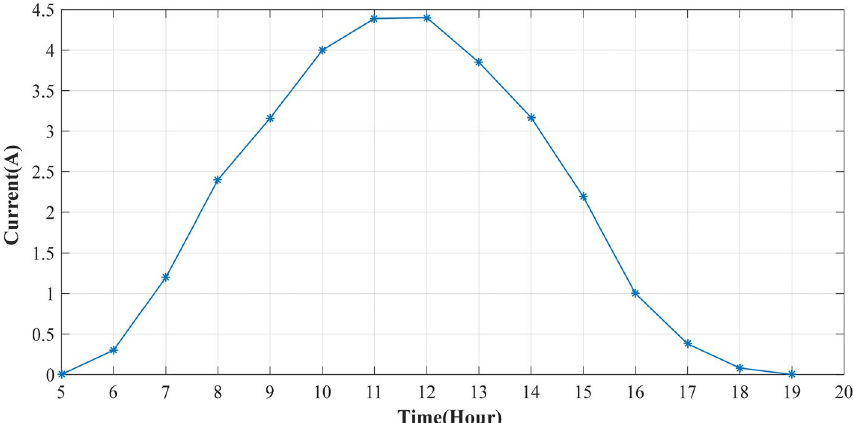
Figure 18. Experimental current of the NST-PV module.